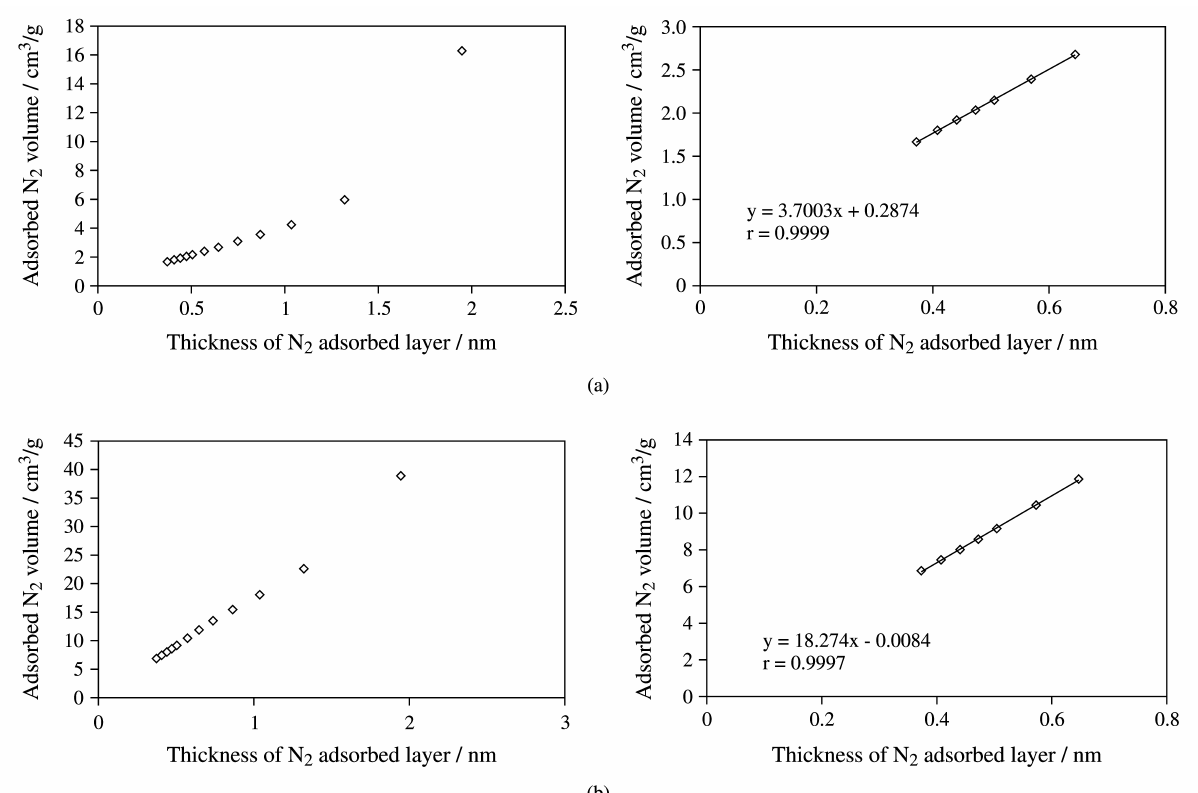
Figure 6. Adsorbed N 2 volume vs. thickness of N 2 adsorbed layer curve and the best fit line, for low pressure values, of adsorbed N 2 volume vs. thickness of N 2 adsorbed layer curve, obtained from nitrogen sorption tests for concrete with f ck of 50 MPa: (a) non heat-treated reference specimens; (b) specimens heat-treated at 600 °C.